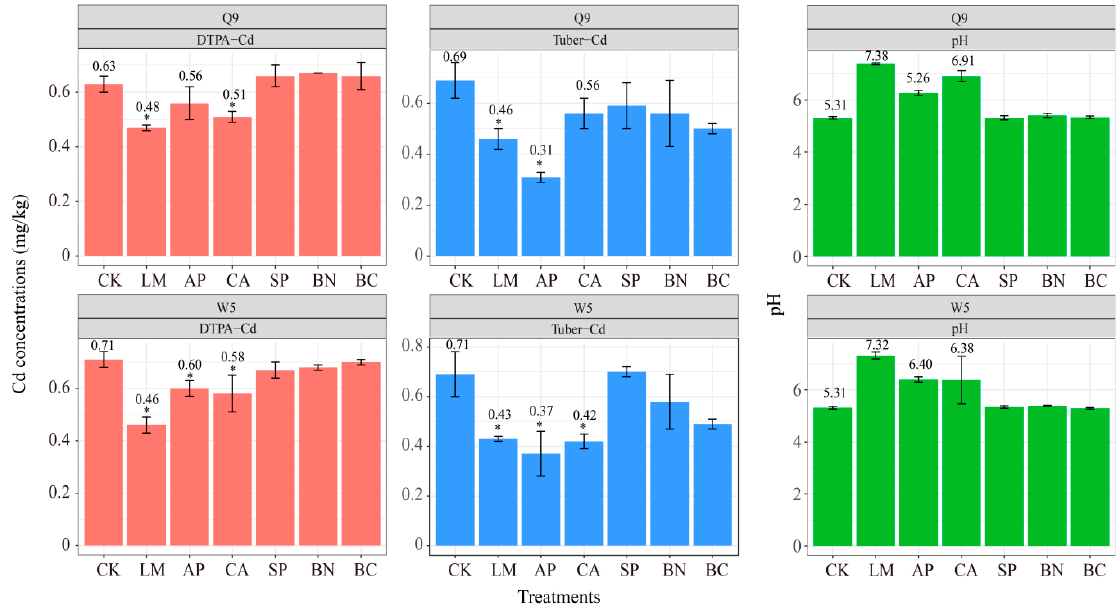
Figure 2. Effect of different treatments on pH and bio-available Cd (DTPA-Cd) of soils, and Cd concentrations in potato tubers (Tuber-Cd); asterisks represent a significant difference from control (CK) ( p < 0.05, ANOVA; pairwise-Tukey’s HSD). CK, Control; LM, Lime; CA, Calcite; AP, Apatite; SP, Sepiolite; BN, Bentonite; BC, Biochar.